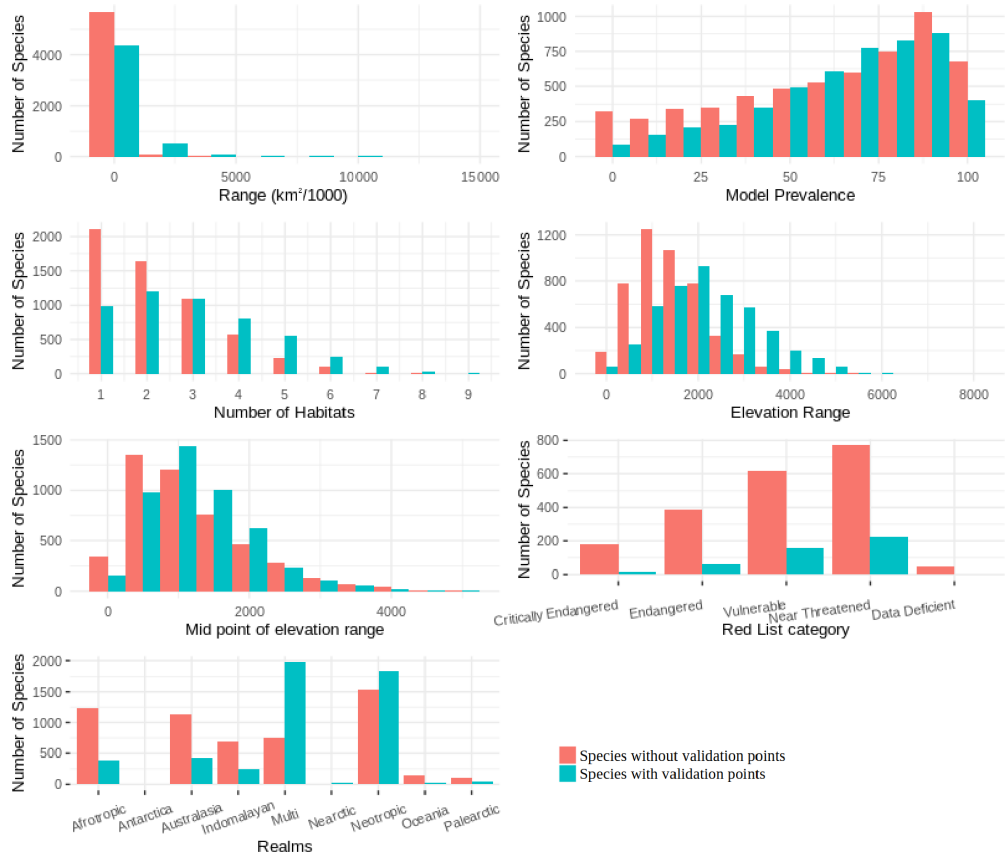
Figure A7. Comparison of species with and without validation points for birds.